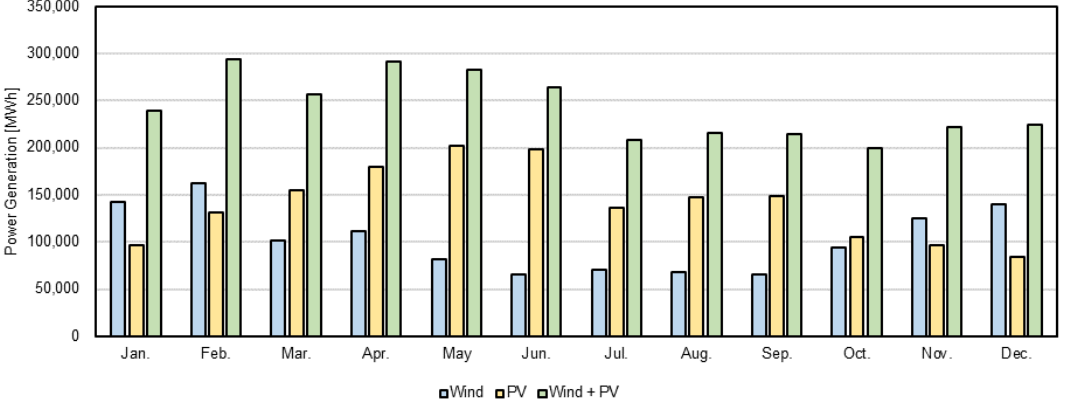
Figure 2. Average daily VRE power generation of each month for 2030.